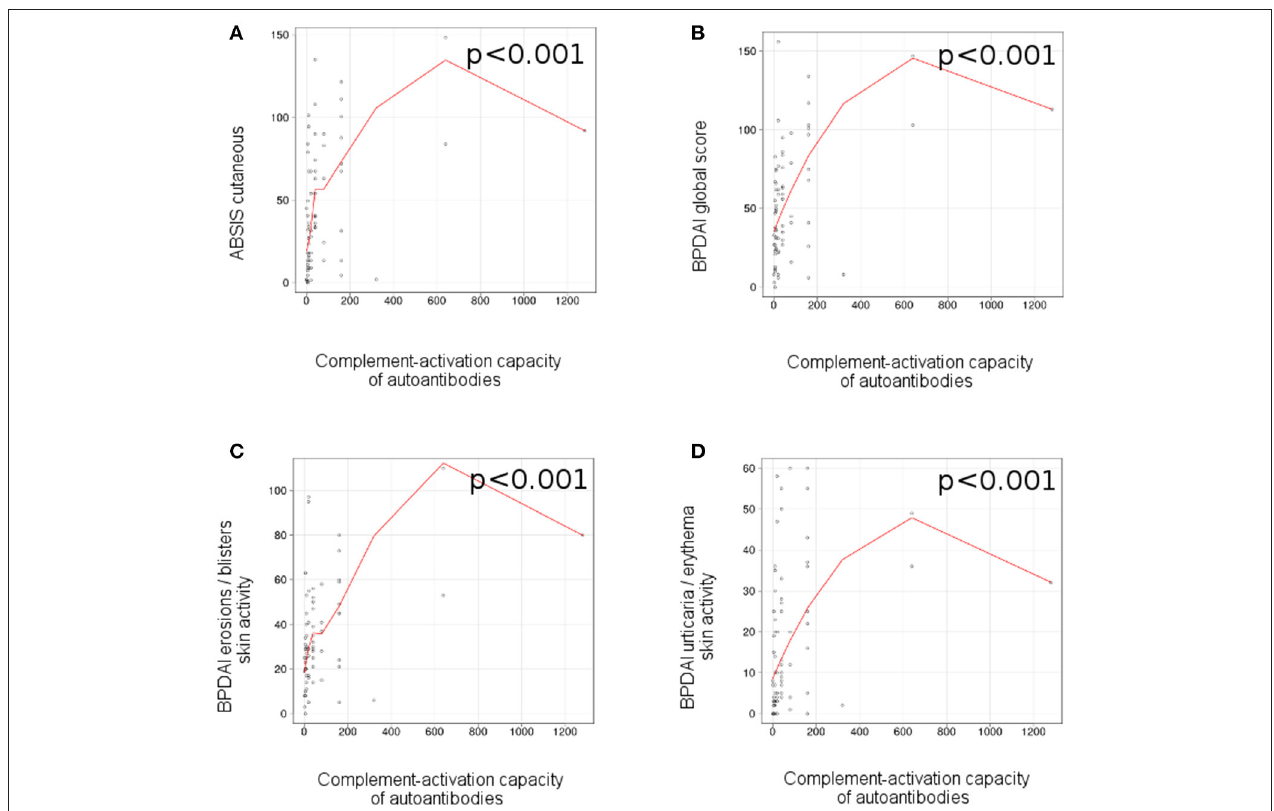
FIGURE 5 | Ex vivo complement-activation capacity of autoantibodies correlates with disease activity in patients with bullous pemphigoid. Relation of ex vivo complement-activation capacity of autoantibodies with disease activity: (A) , ABSIS score of cutaneous involvement; (B) , BPDAI global score; (C) , BPDAI erosions / blisters skin activity; (D) , BPDAI urticaria/erythema skin activity ( n = 75). The red line represents the locally weighted scatterplot smoothing line.